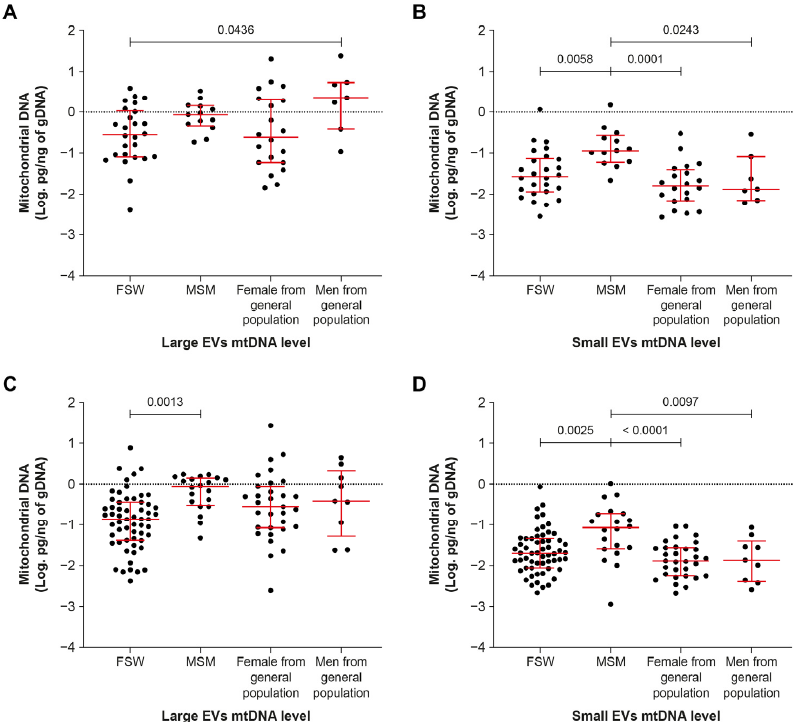
Figure 4. Mitochondrial DNA content of large and small EVs in HIV-infected participant subgroups. ( A , B ) viremic participants; ( C , D ) aviremic participants. FSW—female sex workers; MSM—men who have sex with men. In graphs, the dots represent individual value and lines the geometric mean with geometric standard deviation factor. Ordinary one-way ANOVA with Tukey’s multiple comparisons test was used to reveal significant differences between groups.